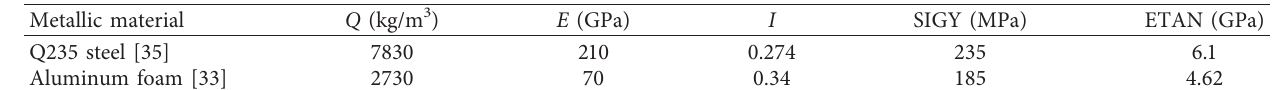
Figure 3: Finite element model generation of aluminum Table 1: Metal material parameters.